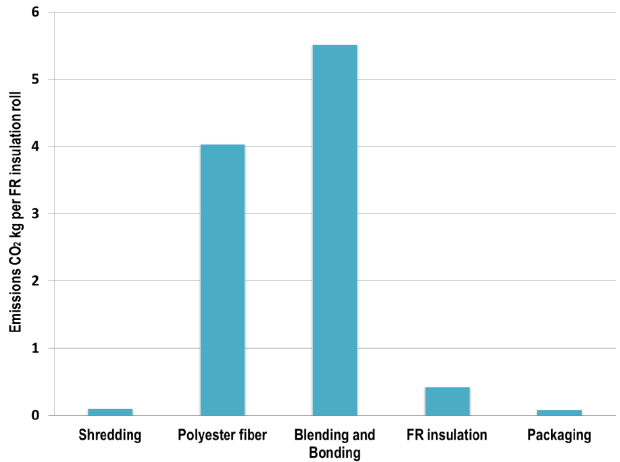
Figure 5. Carbon emissions by one kilogram of FR cotton/polyester insulation.